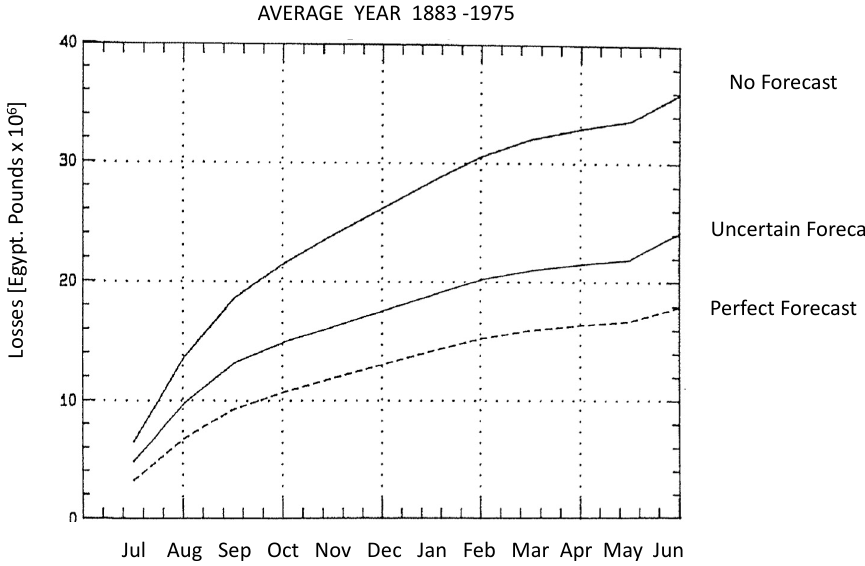
Figure 1. Losses by the Aswan reservoir accrued over one year, depending on the management strategy (reprinted from [3]). The thicker solid line (No Forecast) represents the results of management based on the historical monthly average Nile inflows; the dotted line represents the results of management based on the hypothetical knowledge of future inputs (Perfect Forecast); the thinner continuous line represents the results of a management based on imperfect knowledge of future inputs provided by a simple AR (1) (Uncertain Forecast) forecasting model, while accounting at each time step for the predictive probability distribution in estimating the volume to be released. Note that the information produced, even by a very simple model such as the AR(1), leads to significantly loss reduction (over 65%) by approaching the lower limit of losses obtainable with a perfect forecast, namely the retrospective perfect knowledge of future reservoir inflows